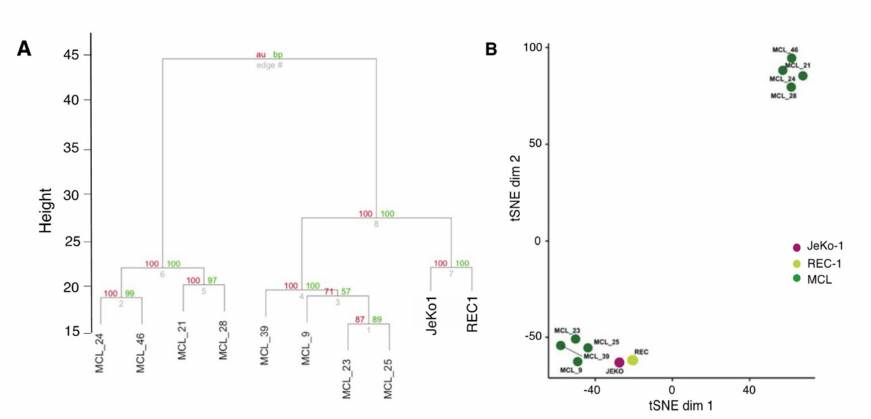
Figure 3. Adhesion-regulated gene expression in cell lines mimics microenvironment-regulated gene expression in MCL patients. ( A ) Dendrogram representation of hierarchical clustering based on log2 fold changes for di ff erentially expressed genes between adherent and suspension JeKo-1 and REC-1 cells and cells of lymph node (LN) versus peripheral blood (PB) origin from MCL (total 684 genes). Clustering only performed using adhesion-dependent di ff erentially regulated genes. ( B ) tSNE representation of data presented in A with perplexity set to